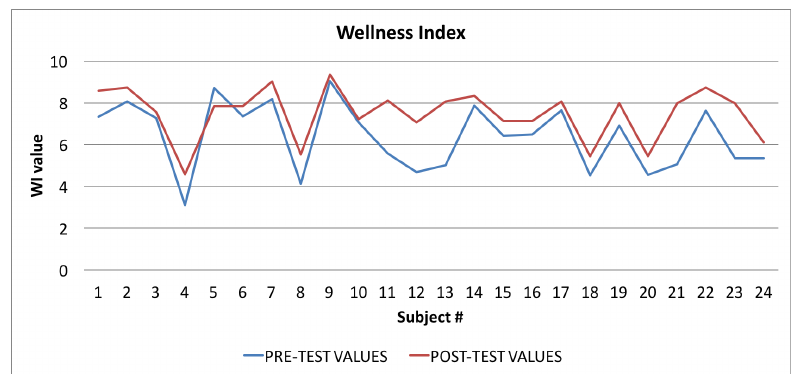
Figure 8. Wellness Index: averages of the values calculated at the beginning (blue line) and at the end of the trial (red line).